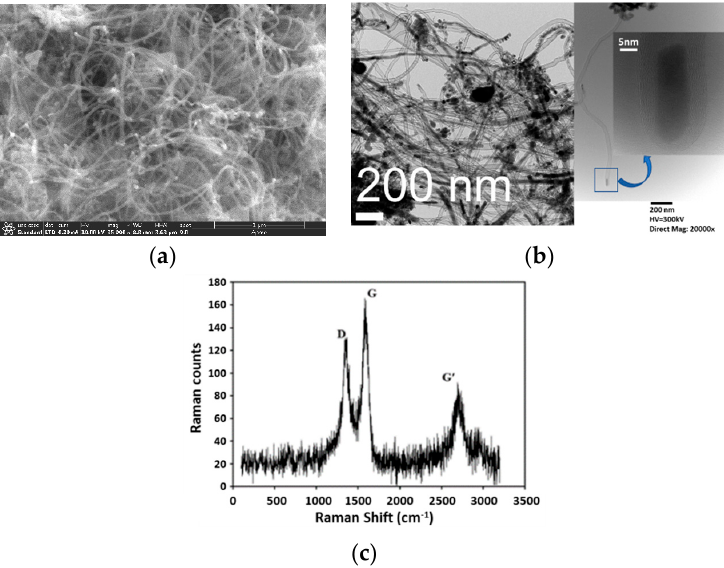
Figure 7. The MWCNTs produced by the FeCr catalyst at 500 °C and 1 bar from the 80%CO + 20%CH 4 mixture feed with 500 ppmv H 2 S: ( a ) SEM image, ( b ) TEM images, and ( c ) Raman shift